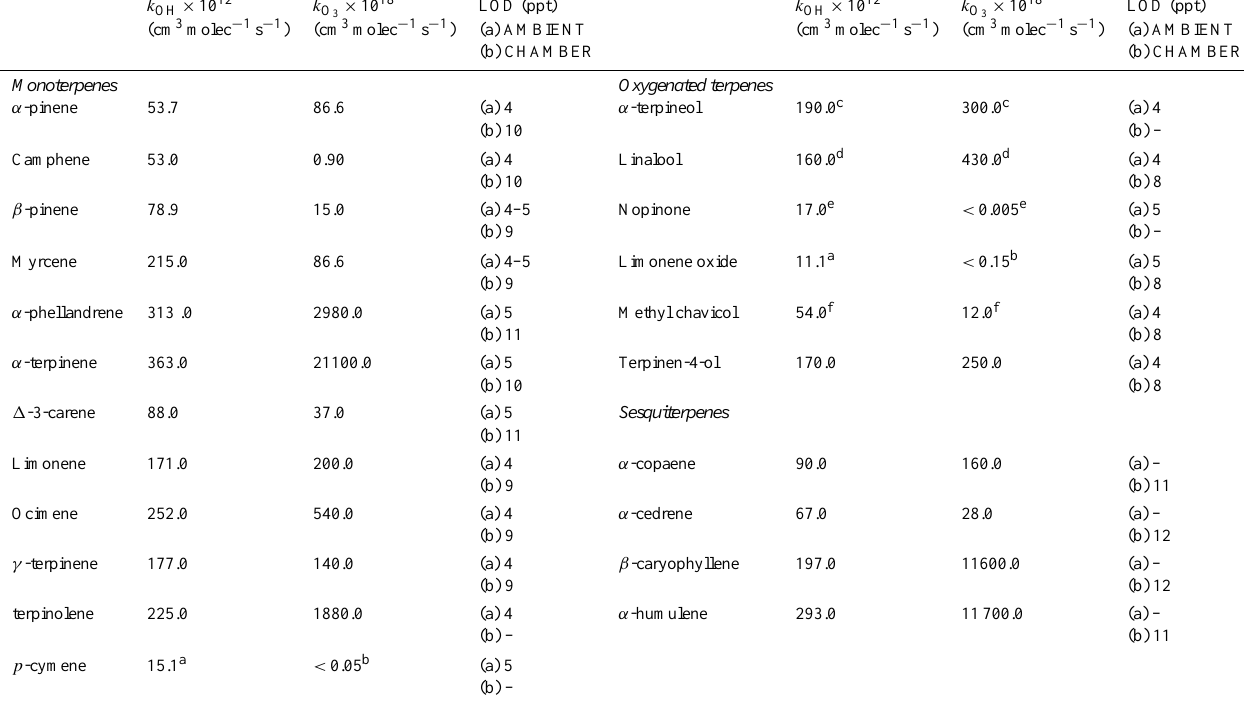
Table 1. BVOC targeted for quantification by Fast-GC, their rate constants with respect to reaction with the atmospheric oxidants OH and O 3 , and limits of detection (LOD) for Fast-GC analysis of these BVOC in plant chamber studies and in ambient